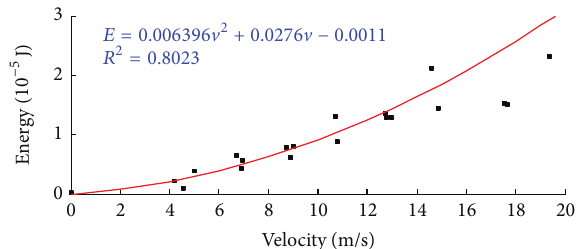
Figure7:RelationshipbetweenthetrueTEMenergyandtheimpact velocity.